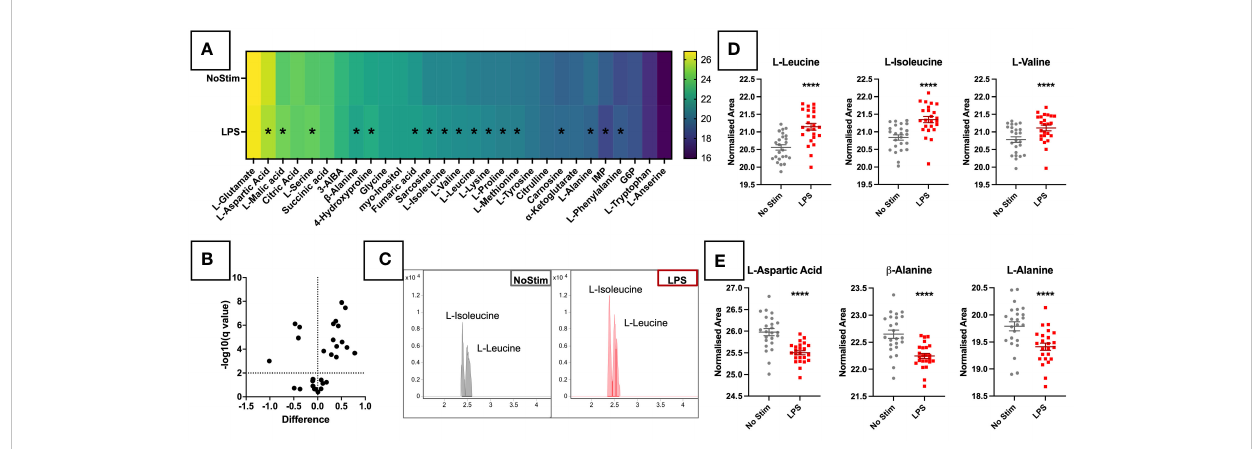
FIGURE 2 Targeted Metabolomic Analysis of LPS Stimulated Primary Monocytes. (A) CD14+ monocytes were stimulated for four hours with 200ng/ml LPS. Monocytes were analysed by LC-MS and targeted metabolomic analysis of 53 metabolites was completed in ESI-. (A) Heatmap of targeted metabolites in LPS-stimulated monocytes. LPS-stimulated monocytes were analysed by LC-MS and targeted metabolomic analysis of 53 metabolites was completed. 29 of the 53 metabolites were detected in experiment samples. Intergroup values are reported as BCA and Log2 normalised AUCs. Signi fi cant metabolites of varying degrees are marked with *. (B) Volcano plot analysis of targeted metabolites in LPS-stimulated monocytes. Metabolite features were analysed by Mann-Whitney paired test with a Benjamini-Hochberg FDR correction, and features with fold change ≥ 1.5 and p value <0.05 were considered signi fi cant. Fold change and p-value thresholds are shown in dotted lines on the X and Y axes, respectively. EICs for leucine and isoleucine are displayed in (C) , and sample plots of BCAAs (D) and metabolites reduced in the LPS-stimulated cells (E) are shown in individual dot plots. TIC, Total Ion Chromatograms; ESI, Electrospray Ionisation; BCAAs, Branched-Chain Amino Acids; EIC, Extracted Ion Chromatogram.*** p <